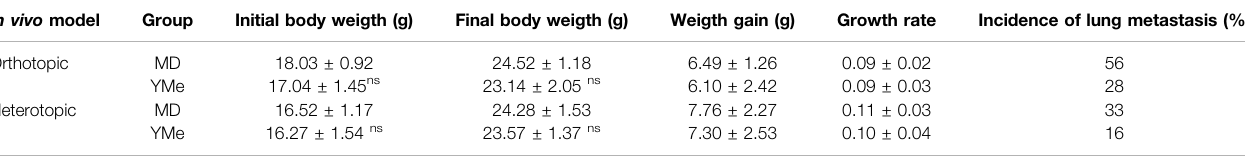
Weigth,ns:nosigni fi cantdifferencebetweeninitialand fi nalbodyweightamongcontrolandtreatedgroups, p > 0.05vs.controlgroup(MD),StatisticalanalysiswasdoneusingStudent ’ s t test. Incidence of lung metastasis, de fi ned as the number of mice with metastases related to the total number of inoculated ones was evaluated in both models. Statistical analysis was done using Mann-Whitney test. Orthotopic model p (cid:2) 0.18 vs. control group. Heterotopic model p > 0.99 vs. control group.